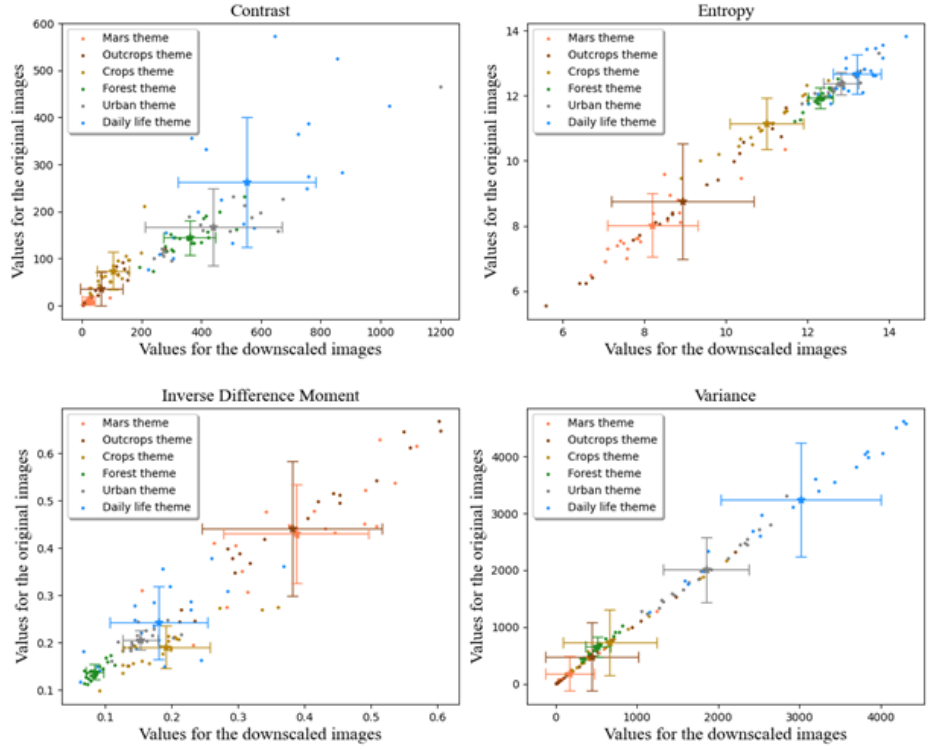
Figure 9. Values that were obtained for four indices that were derived from the Haralick co-occurrence matrix for downscaled images and the original images.